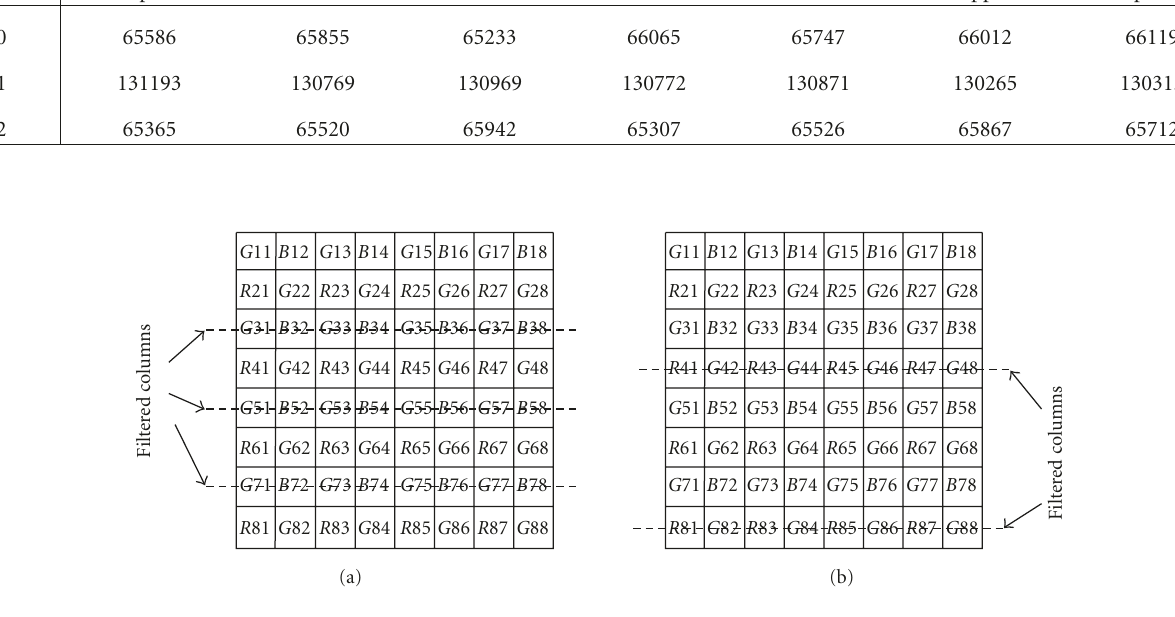
Figure 9: (a) When q = 50%, (b) when q = 25%, dashed lines are in the filtered columns.